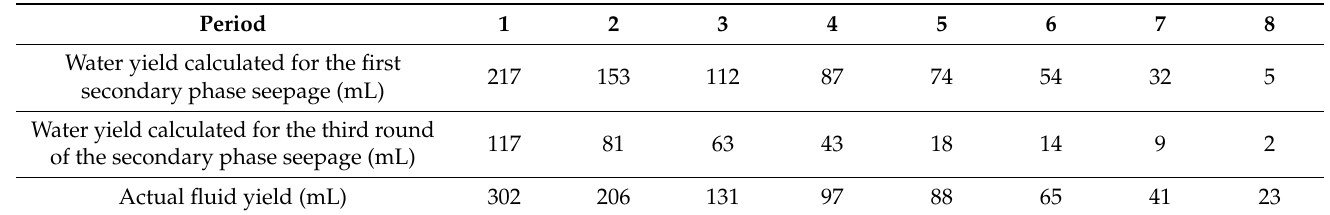
Table 4. Multi-cycle injection and production results calculated from the relative permeability curve of the one-dimensional